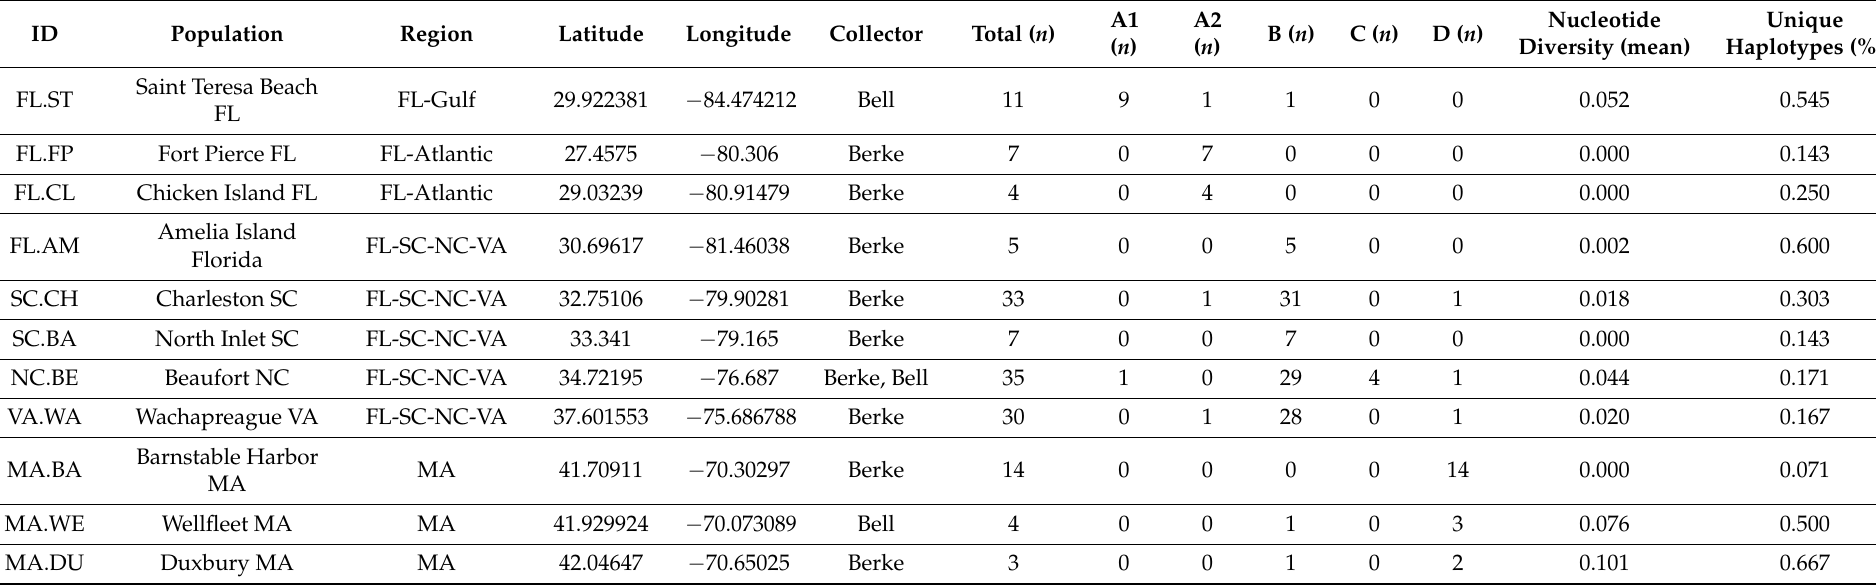
Table 1. Populations collected. We indicate the regions (see text), latitude and longitude, alternative IDs, collector (Sarah Berke or Tina Bell), sample size ( n ), COI haplotype clade frequencies, nucleotide diversity and proportion of unique